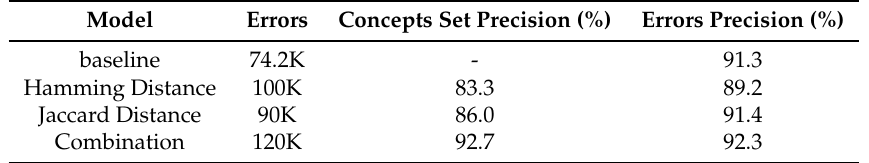
Table 2. Detection